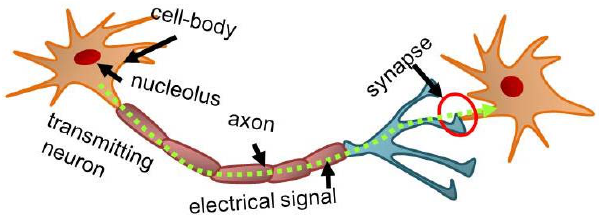
Figure 28. Schematic of biological neurons with synapses in a neural network.